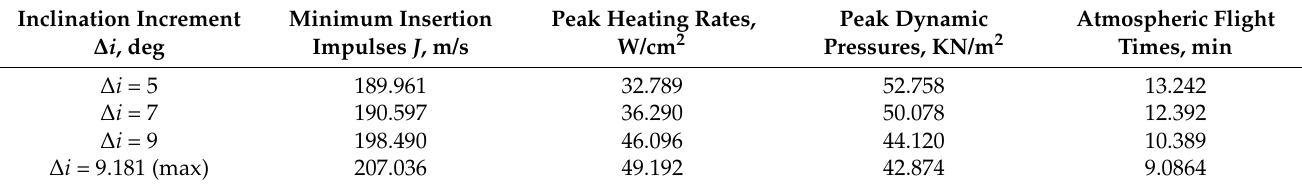
Table 7. Optimal results with different inclination increment